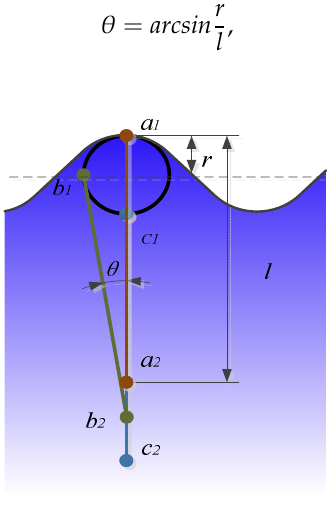
Figure 6. The effect of wave motion on the position of PTO. Figure 6. The e ff ect of wave motion on the position of